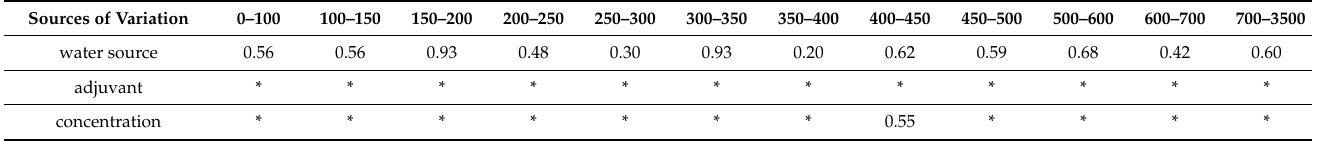
Table 8. Effect of water source, type of adjuvant, and its concentration on drop fraction ( p